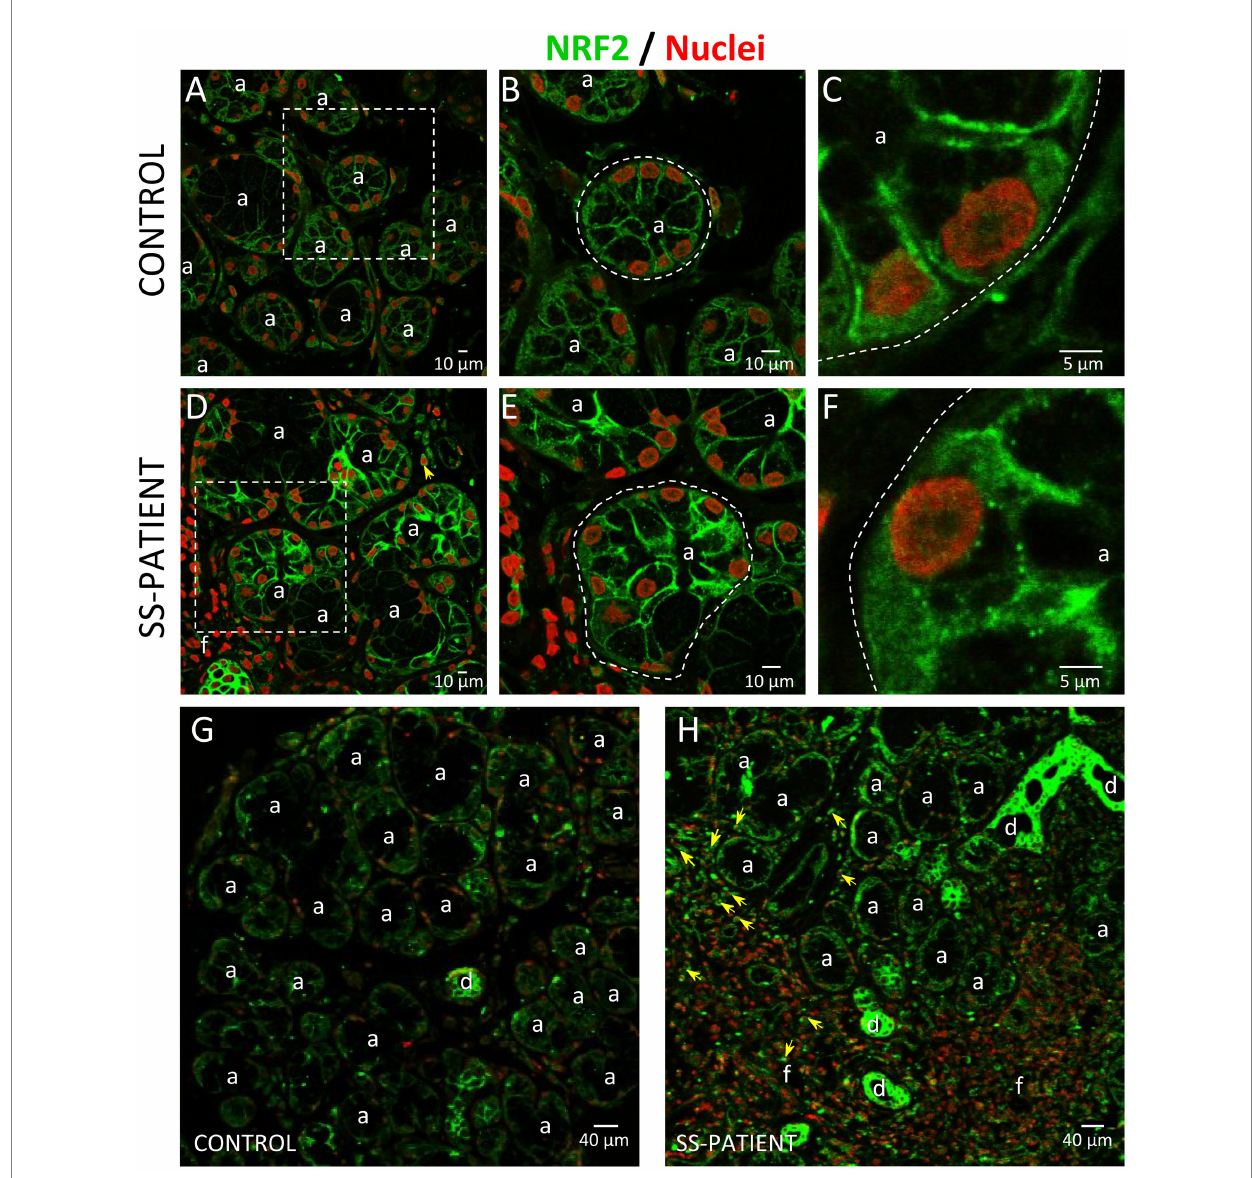
FIGURE 15 Localization of NRF2 in LSGs from control and SS-patients. (A–C,G) NRF2 (green) staining was mainly observed in the basolateral cytoplasm and plasma membrane of epithelial cells in LSGs from control subjects. (D–F,H) Stronger NRF2 (green) staining was observed in the basolateral cytoplasm and plasma membrane of epithelial and plasma cells (yellow arrows) in LSGs from SS-patients. (A,D) Higher magnifications of regions bounded by broken lines in G and H, respectively. (B,C,E,F) Higher magnifications of regions bounded by broken lines in A and B, respectively. Nuclei (red) were counterstained with Hoechst-33342. a: acini; d: duct; f: focus of inflammatory cells. Bars A, B, D, and E: 10 μ m; C and F: 5 μ m; G and H: 40 μ